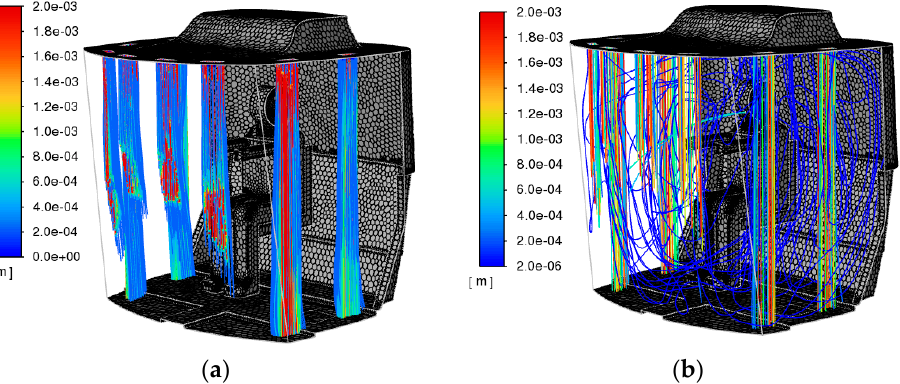
Figure 12. Trajectories and diameters of pathogen particles for deflectors, the colors on the value scale correspond to the size of particle diameters ( a ) with volatility and ( b ) without volatility.